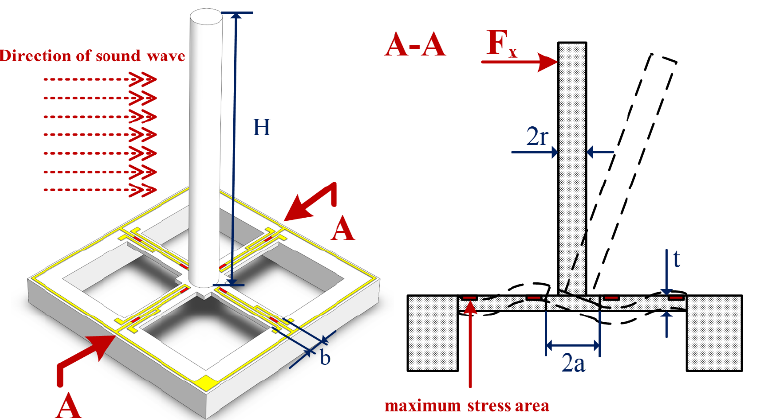
Figure 2. The CVH structure. The acoustic wave generates a force Fx on the cilium, which causes the mass block to drive the beam into deformation. The maximum stresses generated by the deformation are located at the ends of the beam